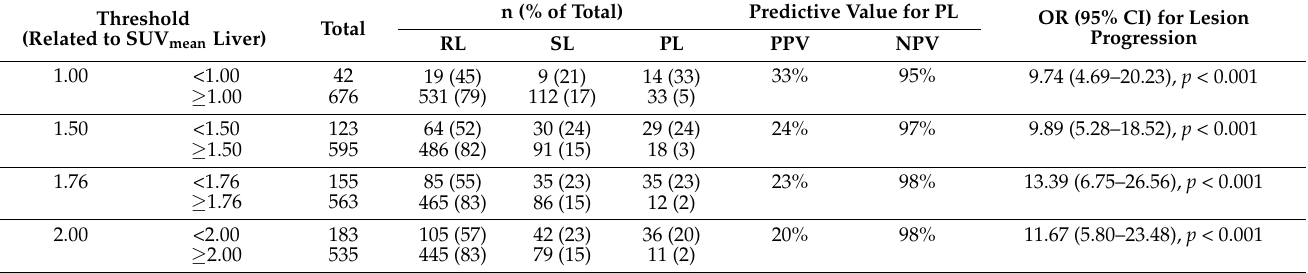
Table 3. Lesion response stratified by various liver-derived threshold values. Data presented as n (%). RL: responding lesions, SL: stable lesions, PL: progressive lesions, TLR: tumor-to-liver ratio, PPV: positive predictive value, NPV: negative predictive value, OR: odds ratio, CI: confidence